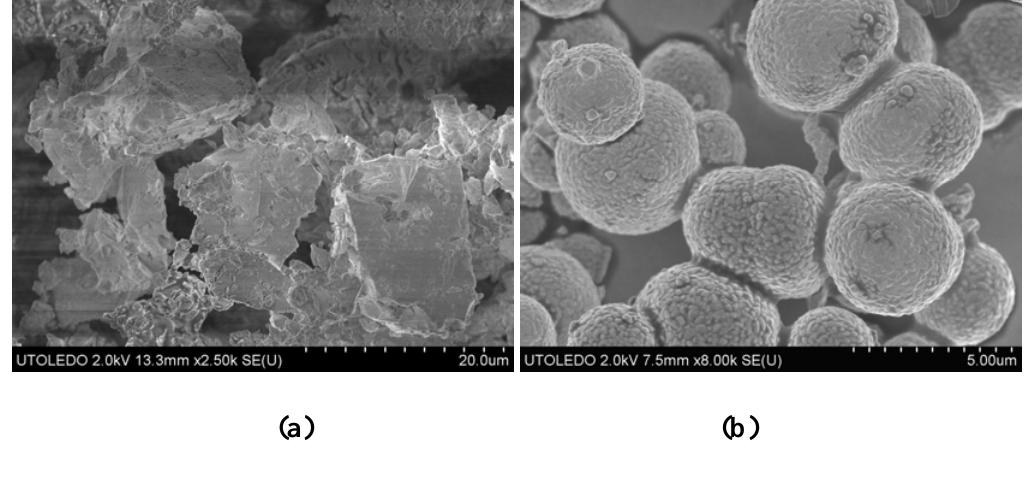
Figure 5. SEM images of MgZrM treatment and (b) non-hydrolytic sol-gel